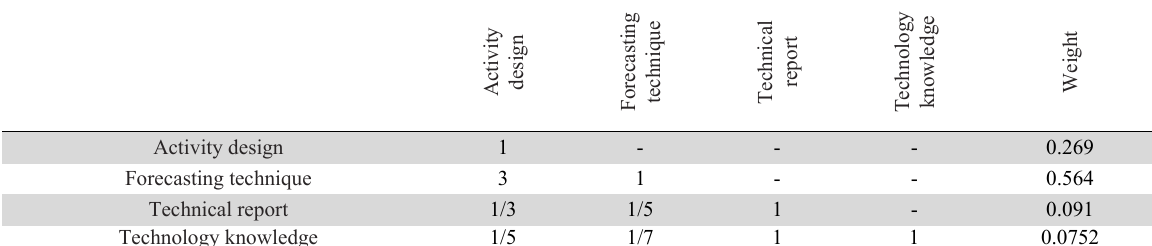
Comparisons in third level, knowledge management and technical skills